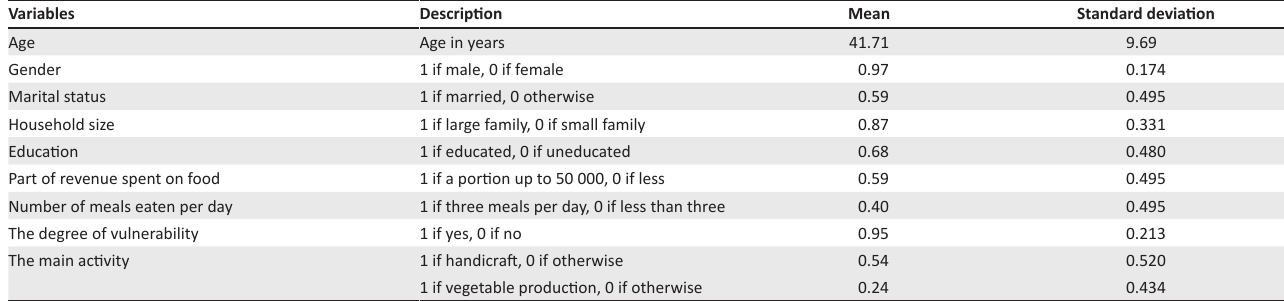
TABLE 2: Characteristics of survey